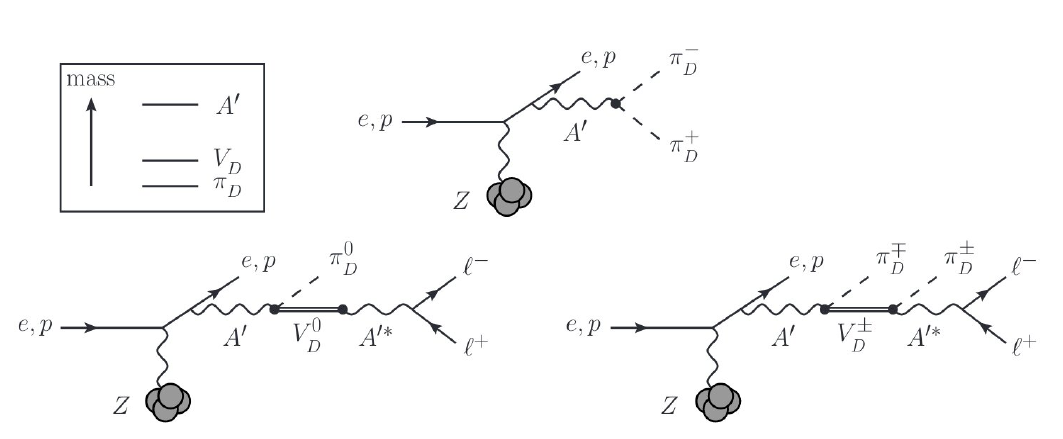
Figure 21: Novel signals from dark mesons coupled to dark photons for fixed target experiments, from Ref. [ 107 ]